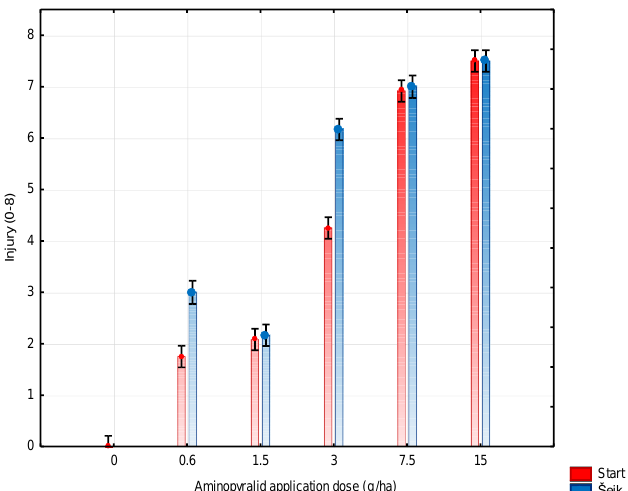
Figure 2. Injury in tomato plants with gradual aminopyralid treatment; ANOVA with Fisher’s LSD post hoc test (α = 0,05; n = 10), bar is a standard deviation, significantly different classes of values were added in separate Table S2 in Supplementary Materials.